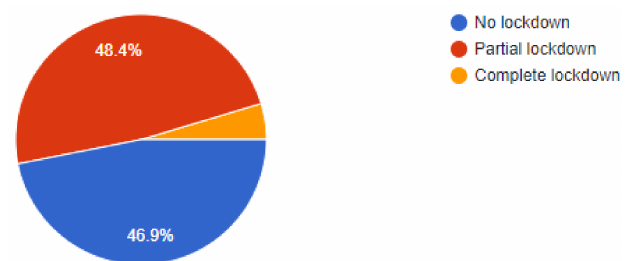
Figure 3. Current state of Lockdown.